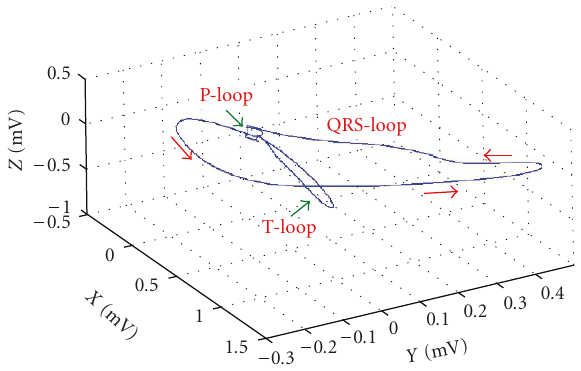
Figure 3: Typical synthetic VCG loop. Arrows indicate the direc- tion of rotation. Each clinical lead is produced by mapping this tra- jectory onto a 1D vector in this 3D space.